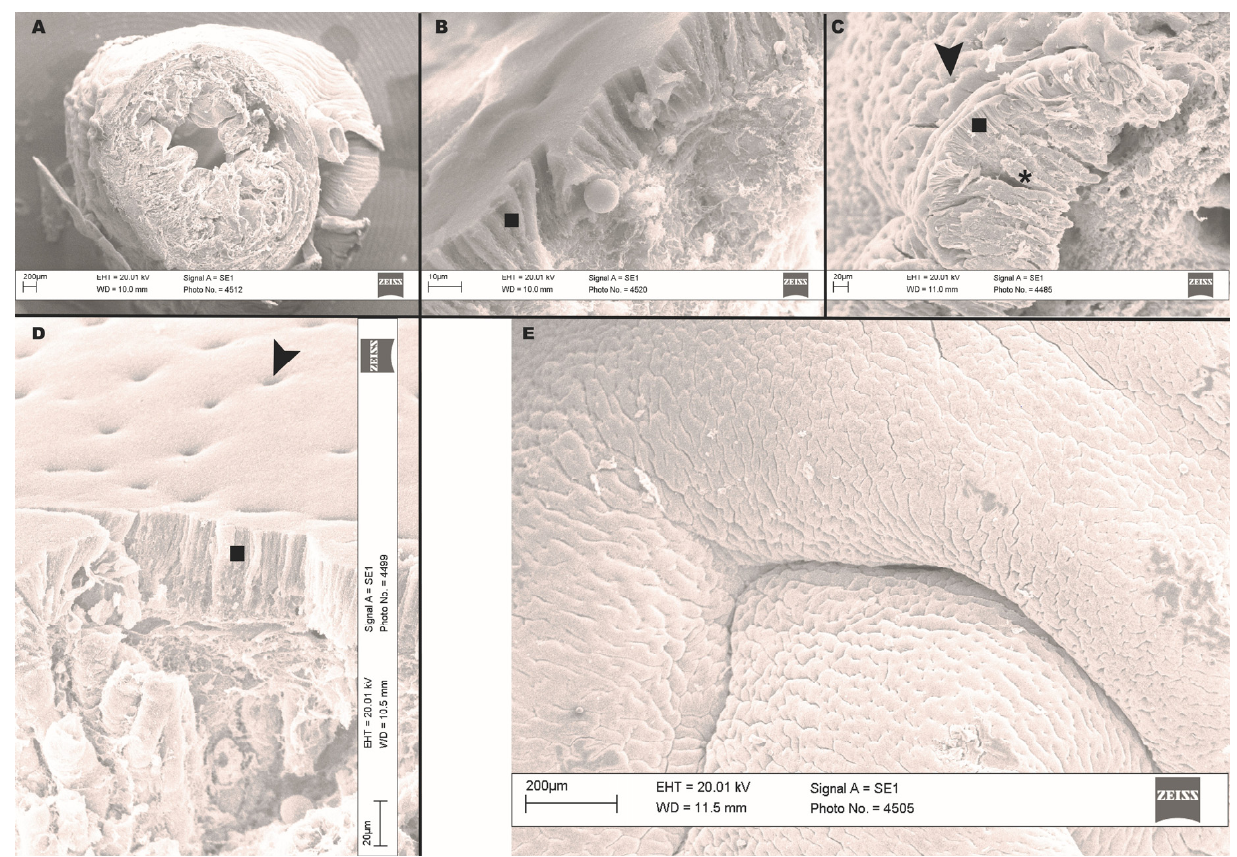
Figure 7. Scanning electron microscopy (SEM) images of esophagus and stomach of Nile tilapia. ( A ): cross section of esophagus. The four layers are clearly evident: serous, muscular (inner circular and outer longitudinal), submucosa and mucosa, featuring folds of different heights; ( B ): esophagus–gastric lumen transition. This section shows a single layer of columnar epithe- lial cells (square) and gastric glands. Vessels are evident in the submucosa; ( C ): descending glandular portion of the stomach. The outlets of the gastric pits (arrow heads) are noted, as well as the epithelial columns lining the mucosa (square) and a gastric gland (asterisk); ( D ): fundic portion of the stomach. Evident columnar epithelium (square) and gastric pits (arrow heads) laying on periglandular con- nective tissue (arrow); ( E ): ascending glandular portion of the stomach. Scale bars are indicated in each